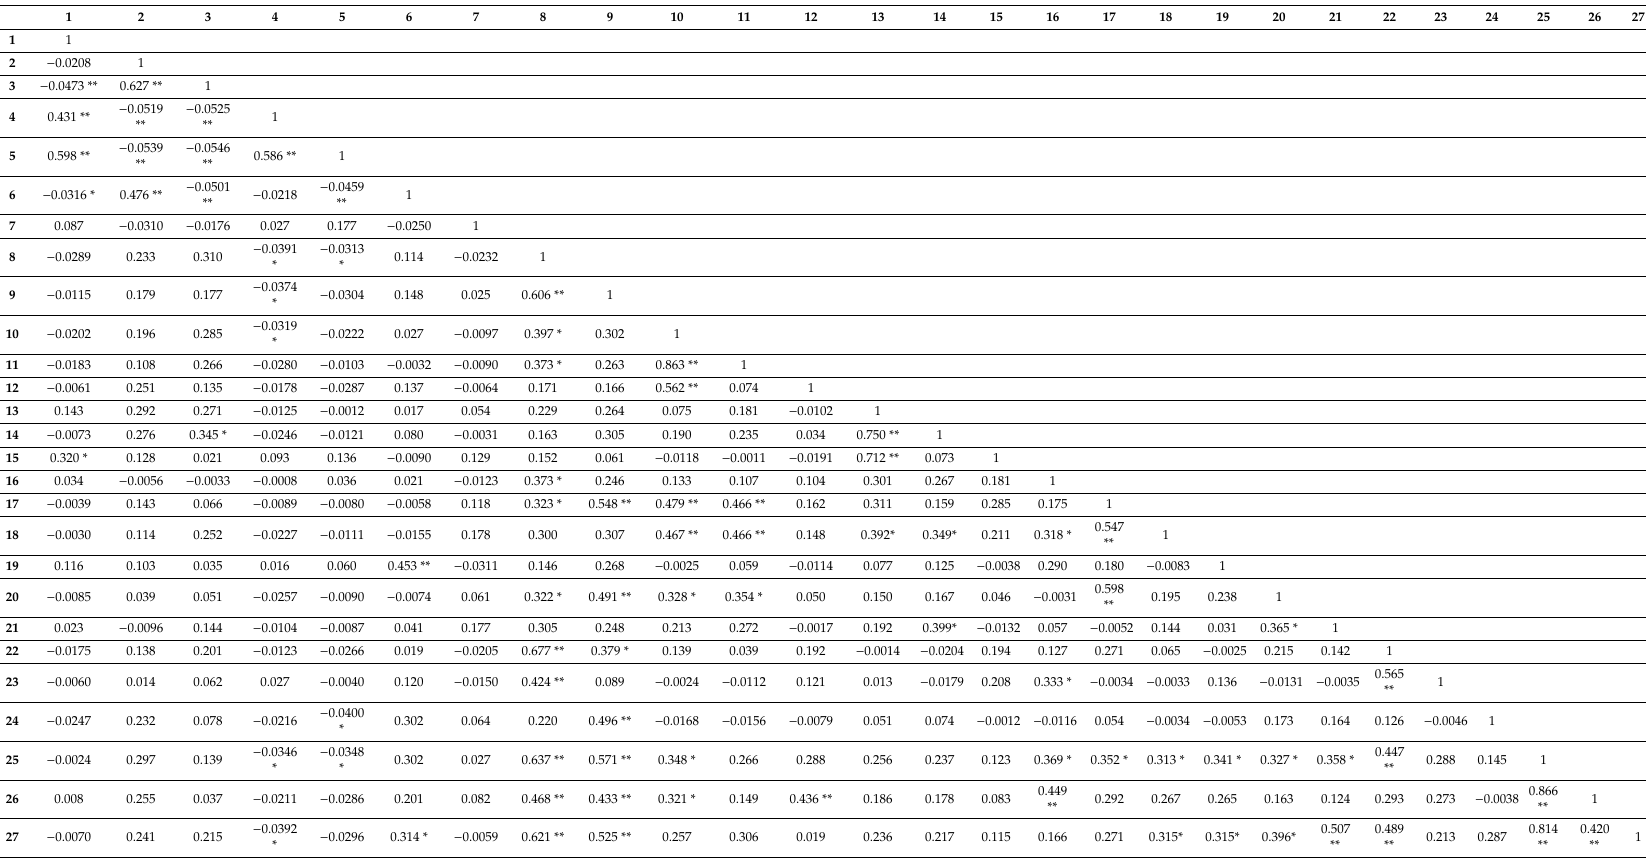
Table 6. Correlations according to the changes in physical and mental health before and after participating in the